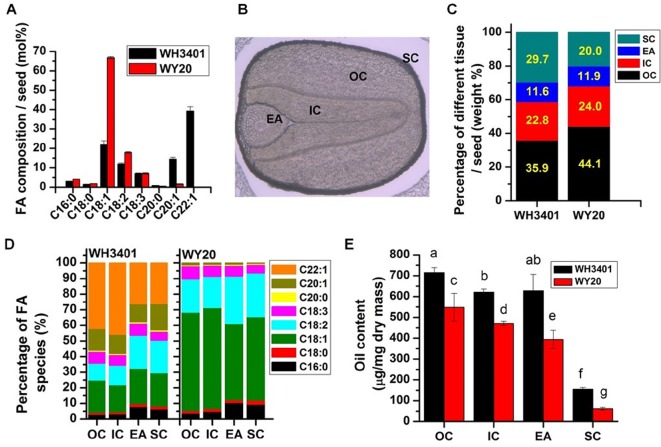
Oil content and fatty acid composition in dissected seed tissues. (A) Fatty acid composition in whole seeds (means ± SD, n = 6). (B) Seed structure under bright-field microscope. (C) Percentage of different tissues in whole seeds. (D) Fatty acid composition of different seed tissues. (E) Oil content of different seed tissues (means ± SD, n = 5–6). Letters denote significant difference at P < 0.05 using ANOVA analysis. FA, fatty acid; EA, embryonic axis; IC, inner cotyledon; OC, outer cotyledon; SC, seed coat.